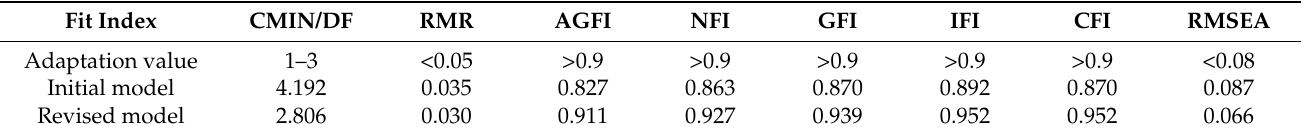
Table 4. Confirmatory factor analysis model fitting